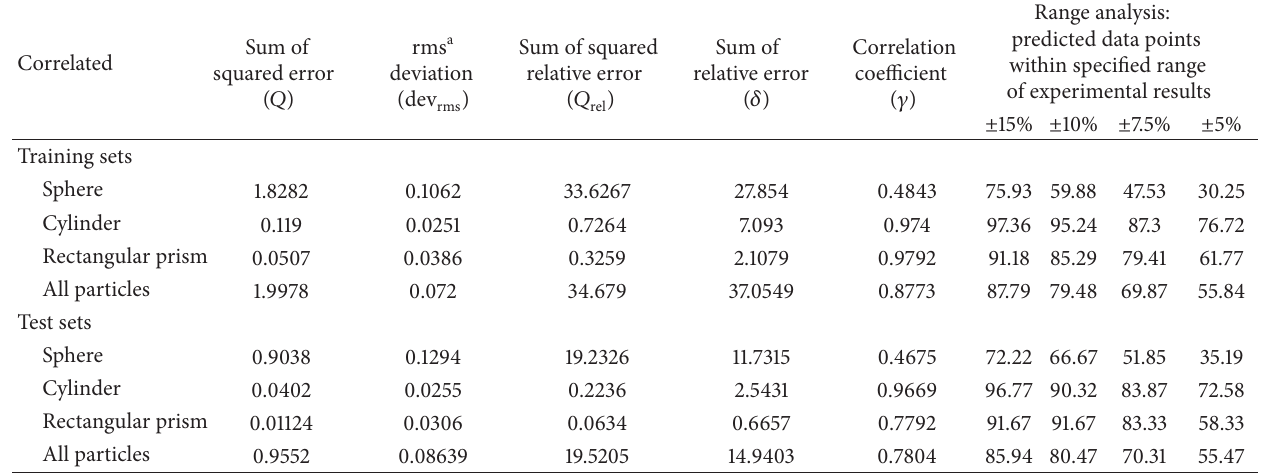
Table 3: Fit of the experimental results to the predicted values of the comprehensive model.